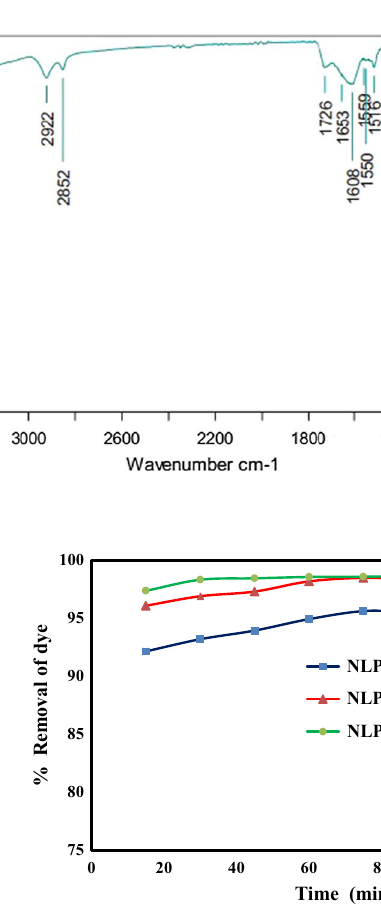
Fig. 5 Effect of adsorbent amount and contact time on MG removal (MG: 100 mg/l, temp: 308 K, pH: